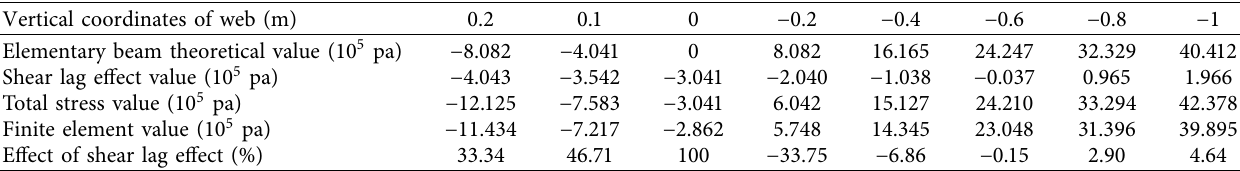
� L � 6m) (concentrated load). 1 2